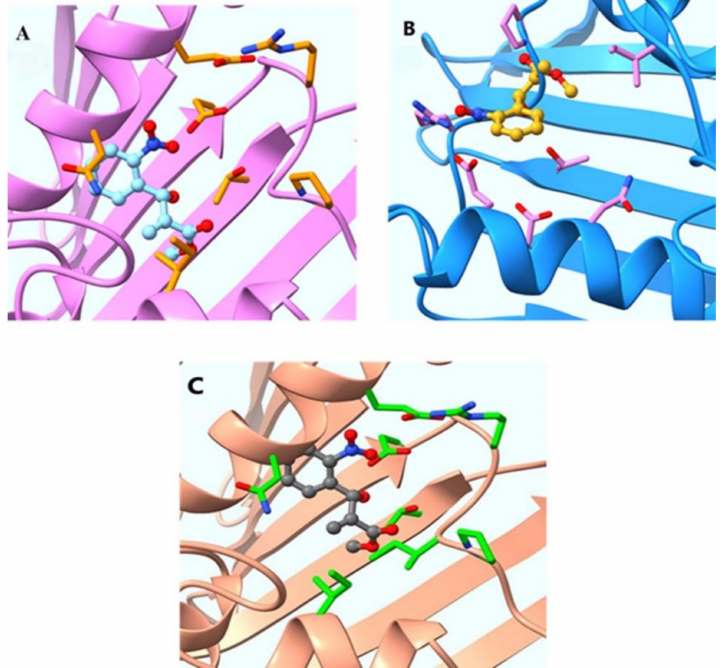
Figure 10. The binding conformations of the MNHA ligand against ( A ) S. typhi , ( B ) S. aureaus , and ( C ) E. coli .